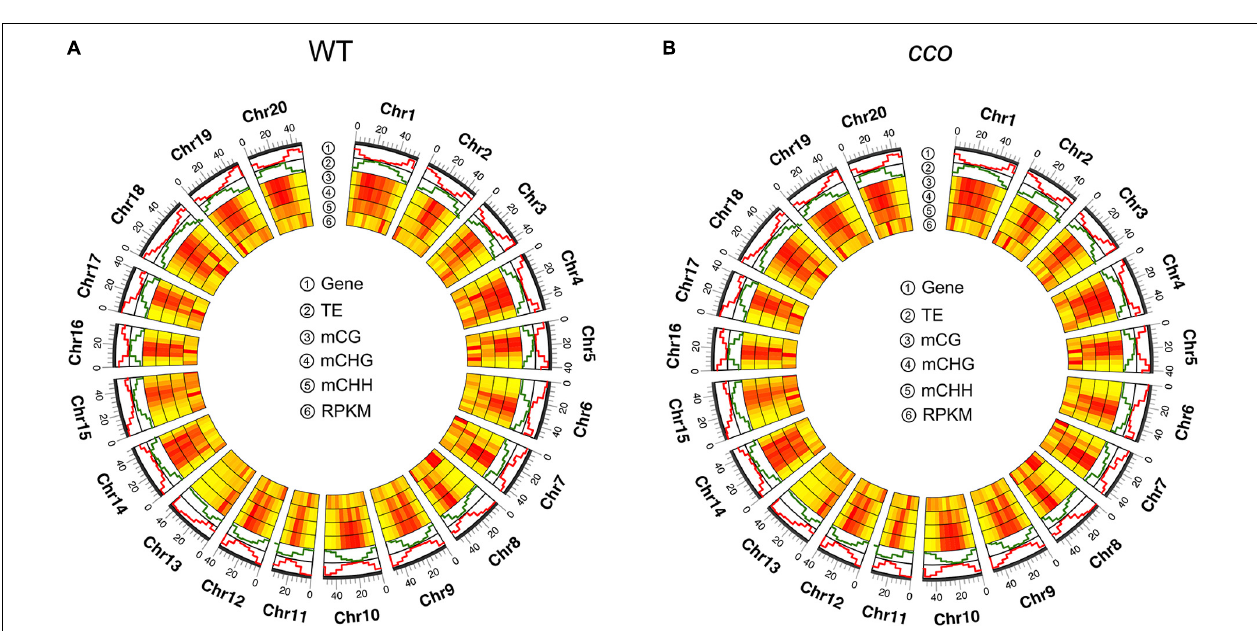
FIGURE 2 | Genome-wide features of DNA methylation between the WT and the cco mutant. (A) Distribution of each context of methylated cytosines in the WT and cco genomes. (B) Genome-wide level of methylated cytosines (mC) and the mC level in three contexts (CG, CHG, and CHH) in the WT and cco genomes.